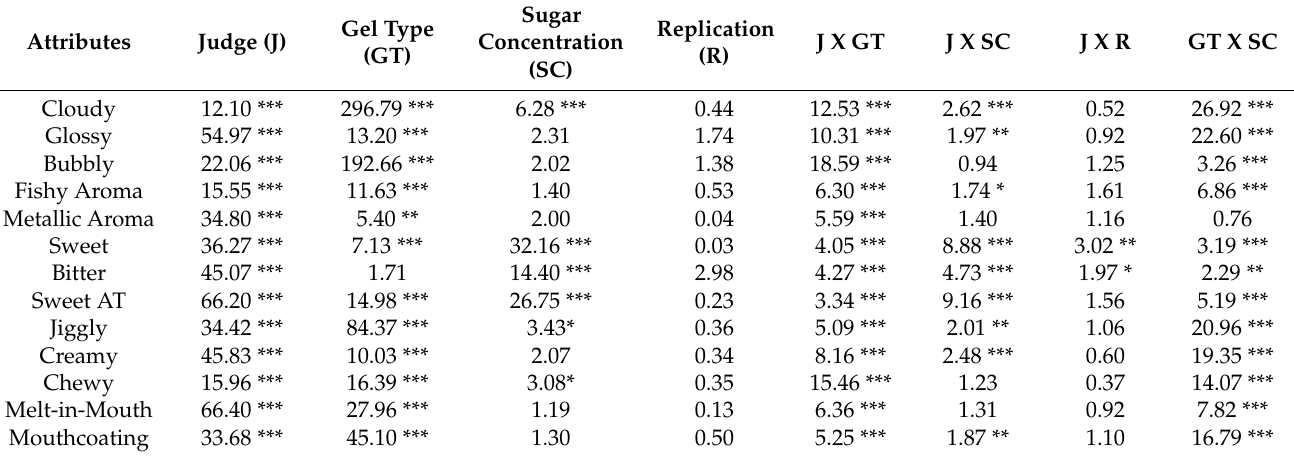
Table 2. Analysis of variance of 13 sensory attributes rated for model confectionary gels samples. F-ratios are shown for the sources of variations and interactions. *, **, *** indicated significance